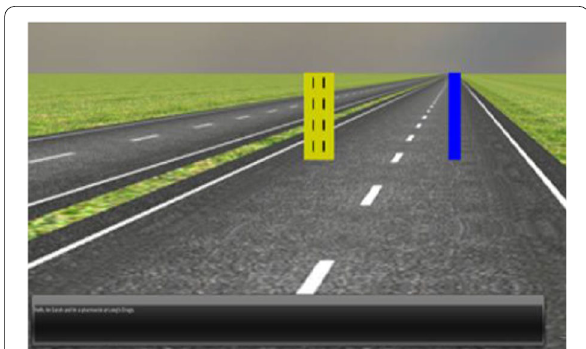
Fig. 6 While participants perform the primary tracking task, text prompts are presented at the bottom of the driving simulator screen